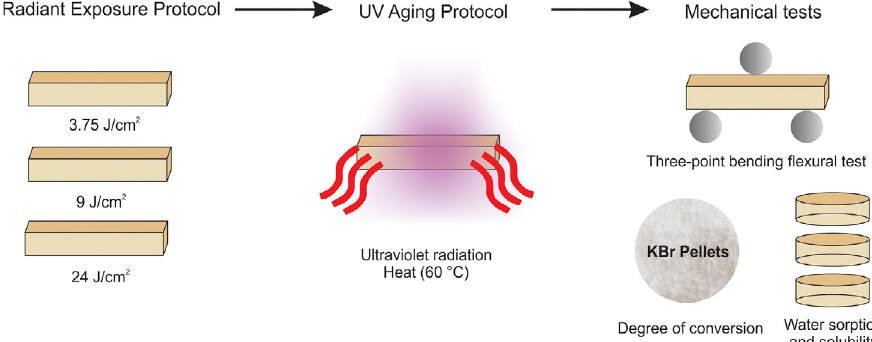
Figure 1- Schematic representation of the study design